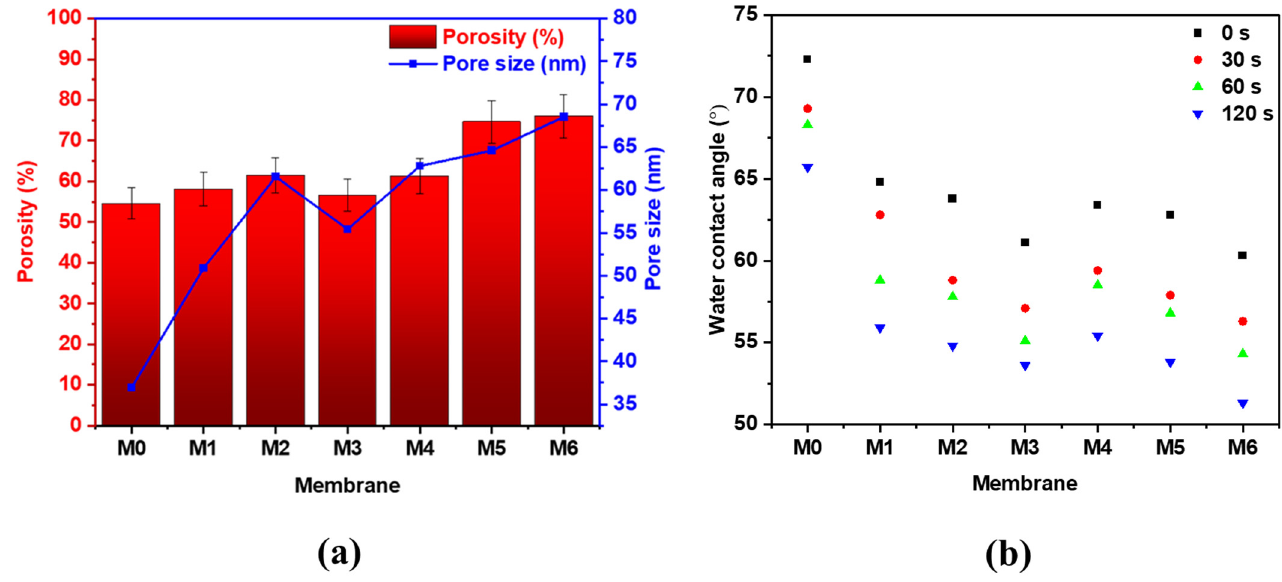
Figure 6. ( a ) Porosity and pore size, and ( b ) WCA at different time intervals of bare PES, PES/MWCNTs, and PES/GO membranes at different loadings of the additives. Table 2. Physicochemical properties for the hybrid ultrafiltration membranes: water uptake; ϕ , contact angles; θ and free surface energy; − ∆ G LS